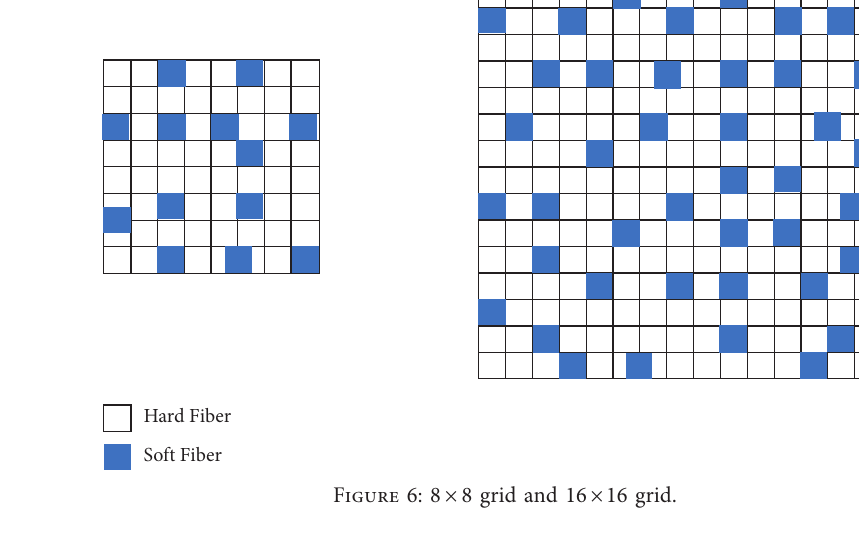
Figure 6: 8 × 8 grid and 16 × 16 grid.